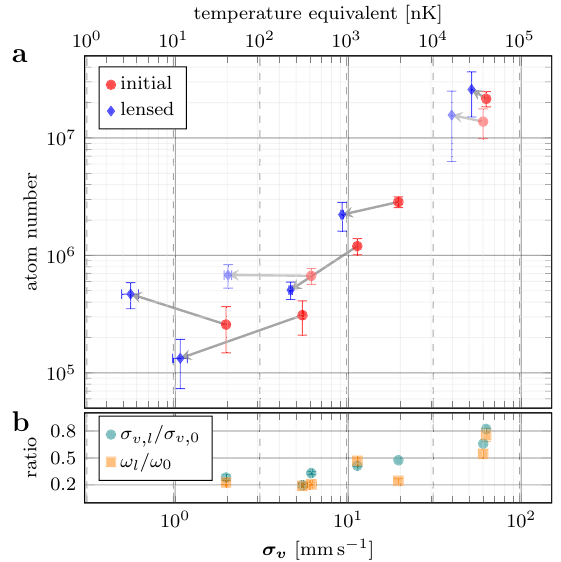
Fig. 3 Expansion velocity dependent performance. Panel a shows the atom number depending on the expansion velocity ( σ v ) for the resulting expansion velocity (blue circles) after the matter-wave lens and starting points (red circles). The lines connect the corresponding data points. The error bars arise from the time of fl ight measurements used to determine the expansion velocity. We use the 1-sigma fi tting error of the ballistic expansion for σ v and the statistical error of measured atom numbers. The two grayed out data points associated with the starting expansion velocities 60 mm s − 1 and 6 mm s − 1 are not displayed in Fig. 2 while all the others are included. Panel b shows the ratio of the lensed and the initial ensembles expansion velocity ( σ v , l / σ v ,0 ) as well as the trapping frequencies ( ω l / ω 0 ) depending on the starting expansion velocity.